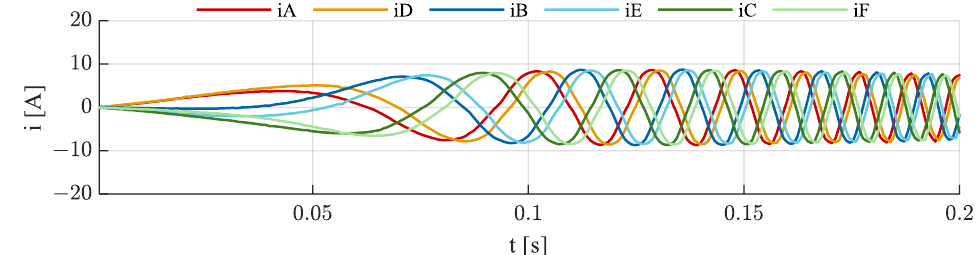
Figure 5. Phase current during the startup transient of the six-phase operation.